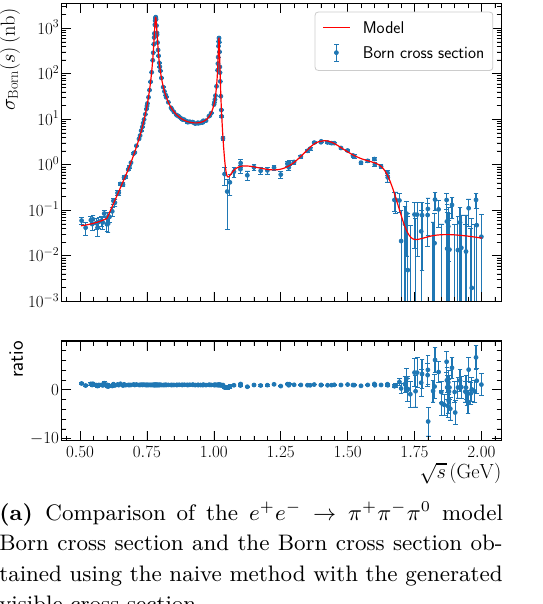
(a) Comparison of the e + e − → π + π − π 0 model Born cross section and the Born cross section ob- tained using the naive method with the generated visible cross section. Figure 8. Comparison of the e + e − → π + π − π 0 model Born cross section with the Born cross section obtained using the naive method. The results shown in the figure are obtained using piecewise linear